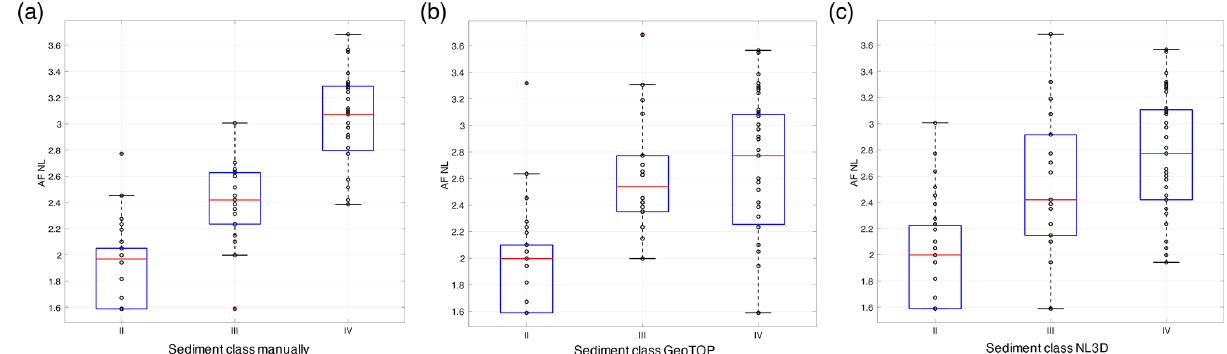
Figure 11. Comparison of calculated AF distribution in terms of manual classification (a) and automatic classification by GeoTOP (b) and by NL3D (c) . The locations where the empirical AF relationship is not valid are eliminated (Classes I and V). The red central mark indicates the median; the bottom and top edges of the box indicate the 25th and 75th percentiles, respectively. The whiskers extend to the most extreme data points, and the outliers (1 . 5 × away from the interquartile range) are plotted individually as red circles.